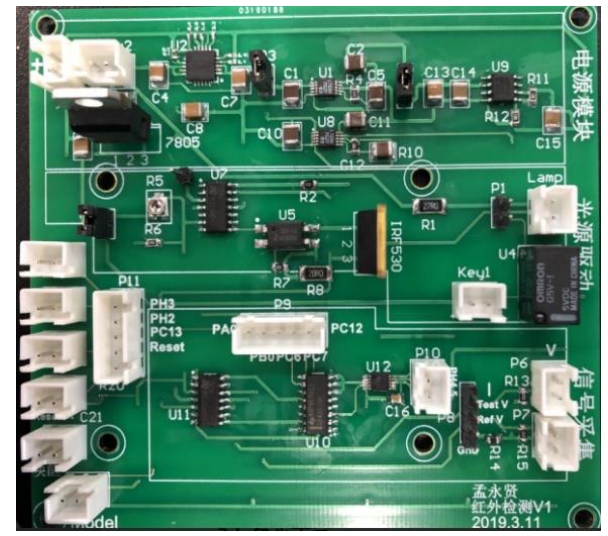
Figure 5. Photo of circuit board.